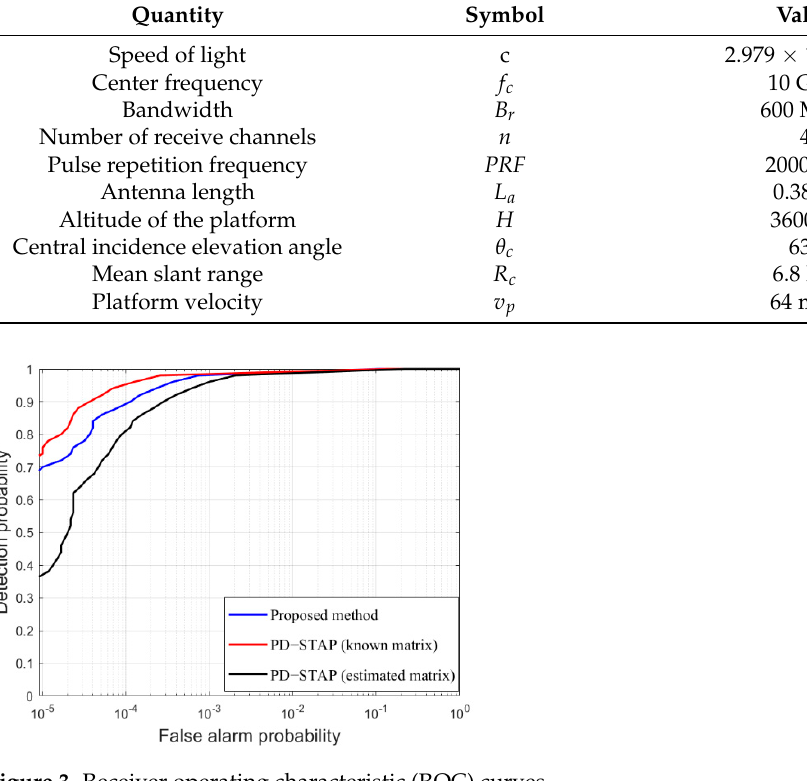
Table 1. System parameters.